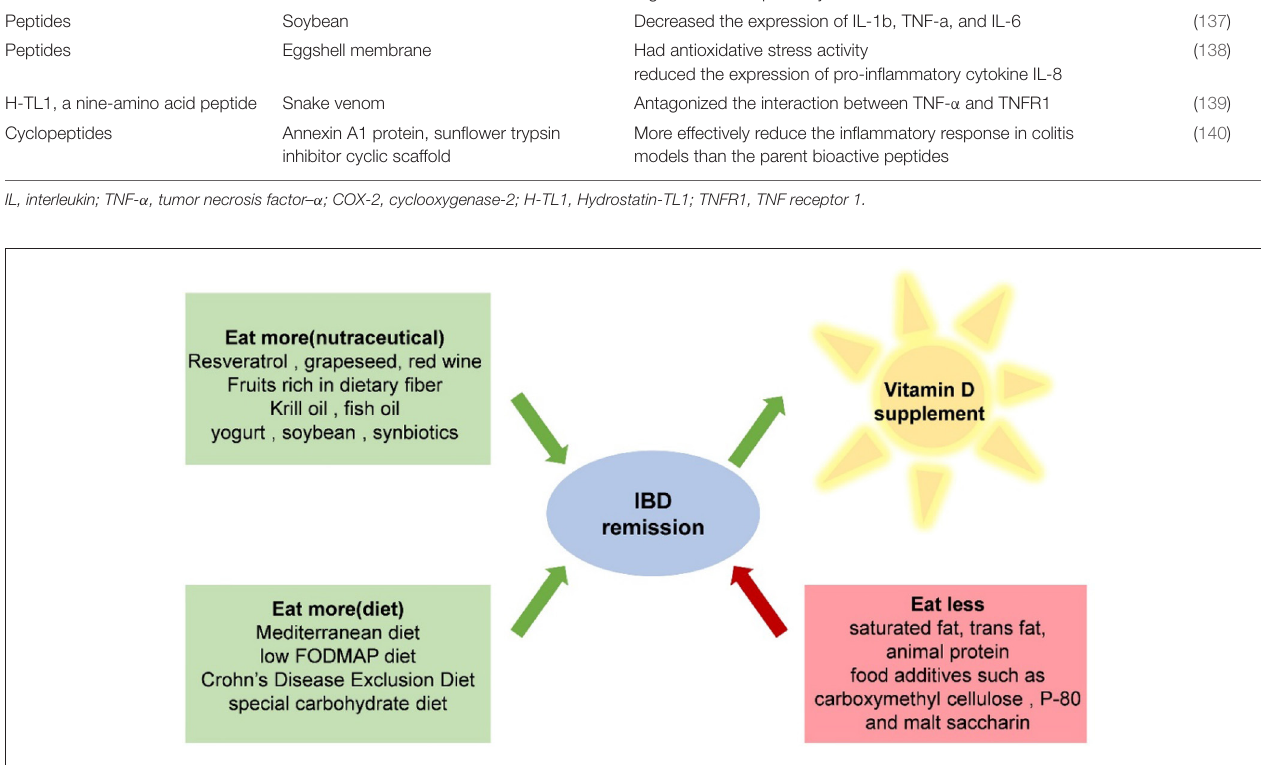
Frontiers in Nutrition |